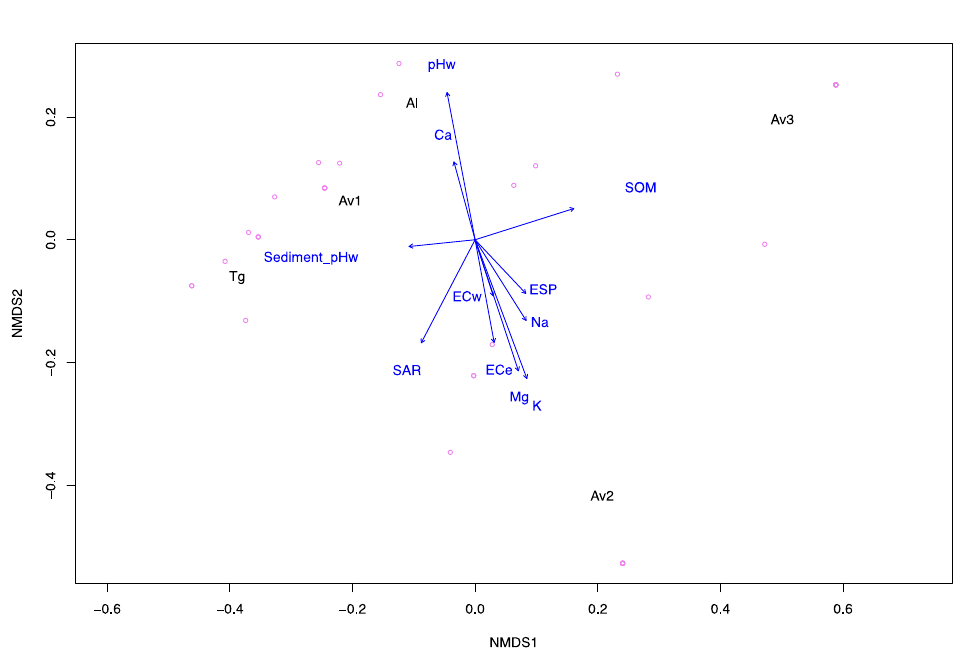
Figure 2. Heatmap showing relative abundance of OTUs in the subsets corresponding to each sampling. Dendrograms show hierarchical clustering between OTUs and sampling sites.